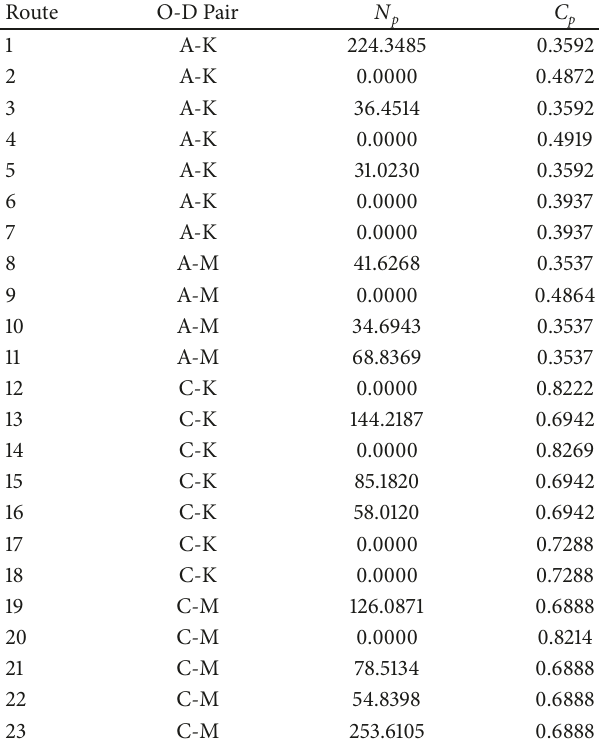
Table 3: Equilibrium Route Assignments, Density-Based Approach (high congestion).